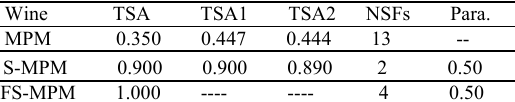
Table 4 TSAs and NSFs for Wine.